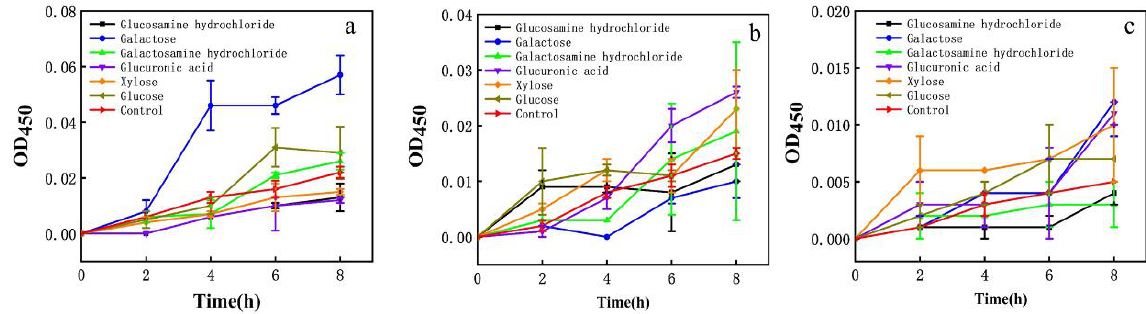
Figure 6. Effect of different monosaccharides on cell membrane impermeability. ( a ) E. coli ; ( b ) S. aureus ; ( c ) H. pylori .